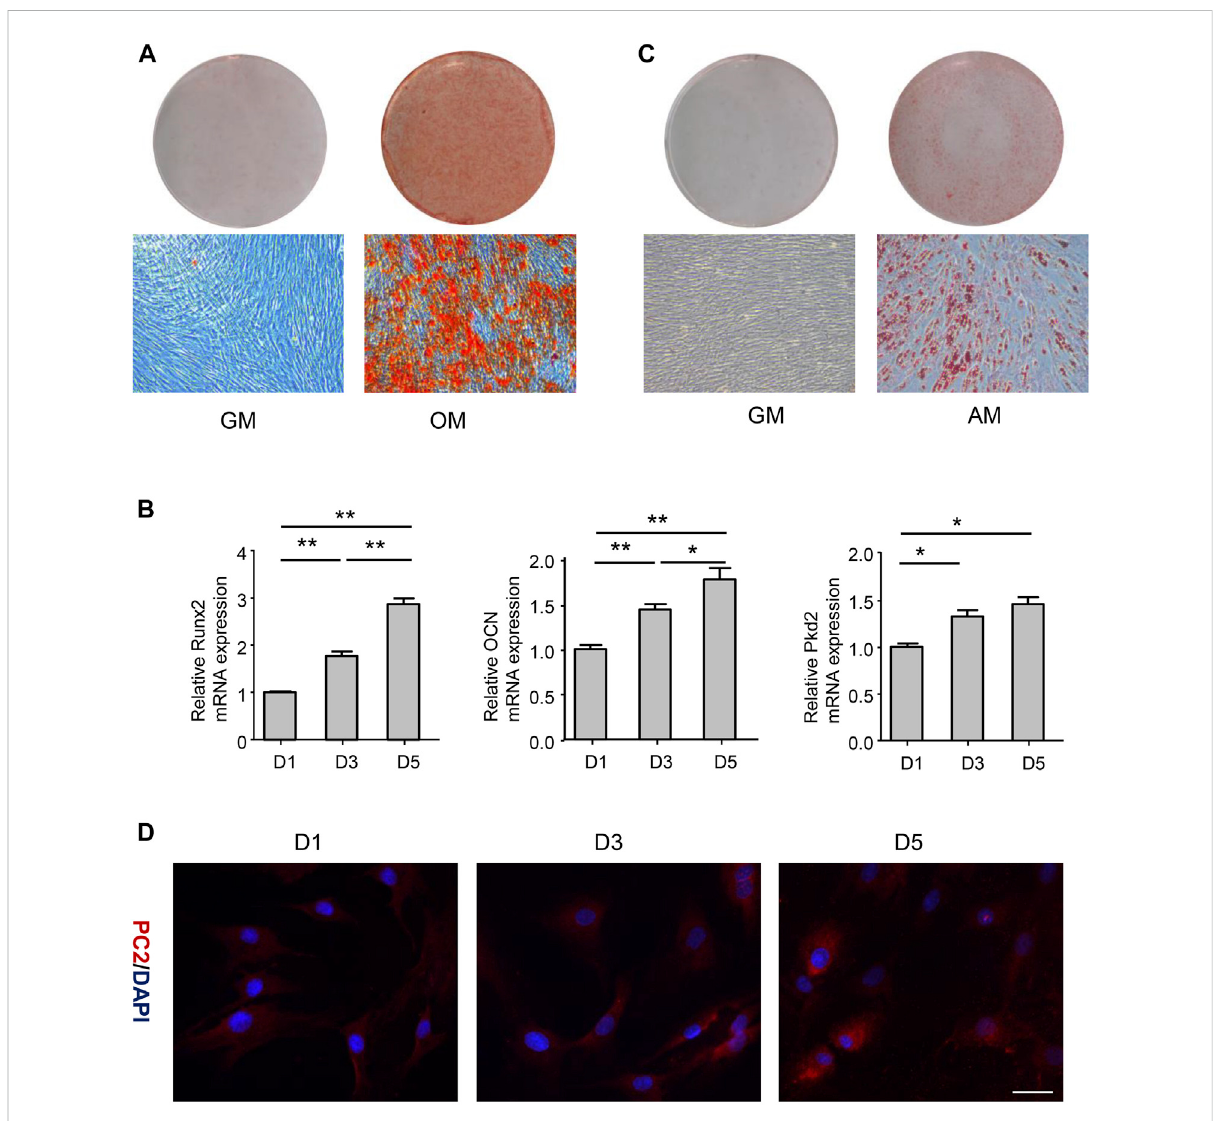
FIGURE 1 PC2expressionwasrelatedtotheosteogenicdifferentiationofhASCs. (A) hASCswereculturedintheosteogenicmedium(OM)for21 days,and Alizarin Red S staining was performed. (B) The mRNA levels of Runx2, OCN and PKD2 were detected by real-time polymerase chain reaction (PCR) after culturing hASCs in OM for 1-, 3-, or 5-day. (C) hASCs were cultured in the adipogenic medium (AM) for 14 days, and Oil Red O staining was performed (D) Immuno fl uorescence staining of PC2 was detected after culturing hASCs in OM for 1-, 3-, or 5-day. Scale bar: 200 μ m. Values are the mean ± SEM. * p < 0.05, ** p < 0.01. Experiments =